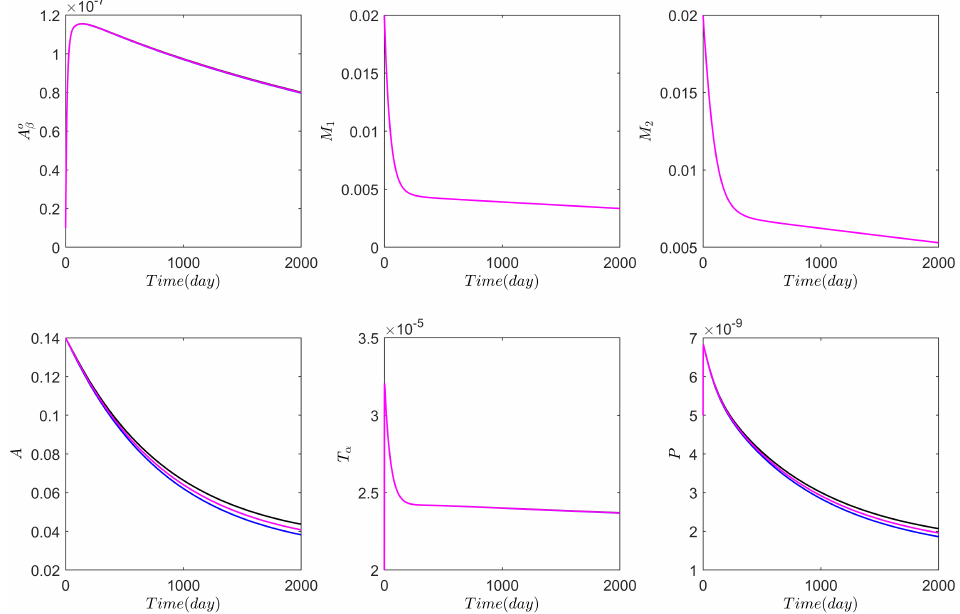
Figure 2. Average solutions of the six variables associated with astrocytes and microglias. We take all the parameter values from Tables 1 and 2. Blue curve: λ AA o = 1.7; magenta curve: λ = 1.793 and λ λ AA o AT α β